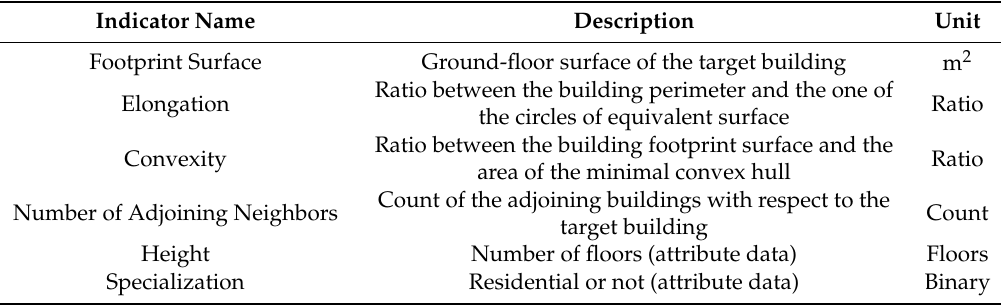
Table A1. List of Calculated Indicators for Building Clustering.